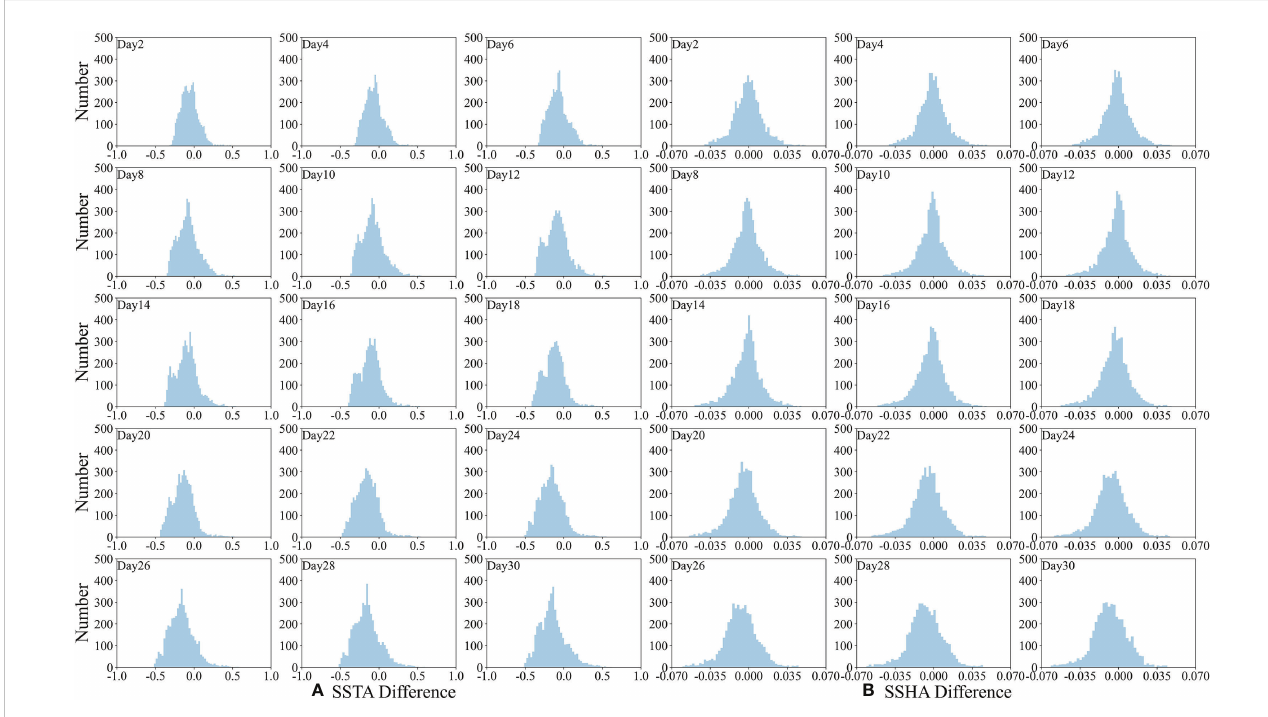
FIGURE 11 Statistics of the SSTA differences (°C) and SSHA differences (m) between the predictions and the observations in 2020. (A) Shows the SSTA differences (°C) and (B) shows the SSHA differences (m) with leading times from 1 to 30 days.